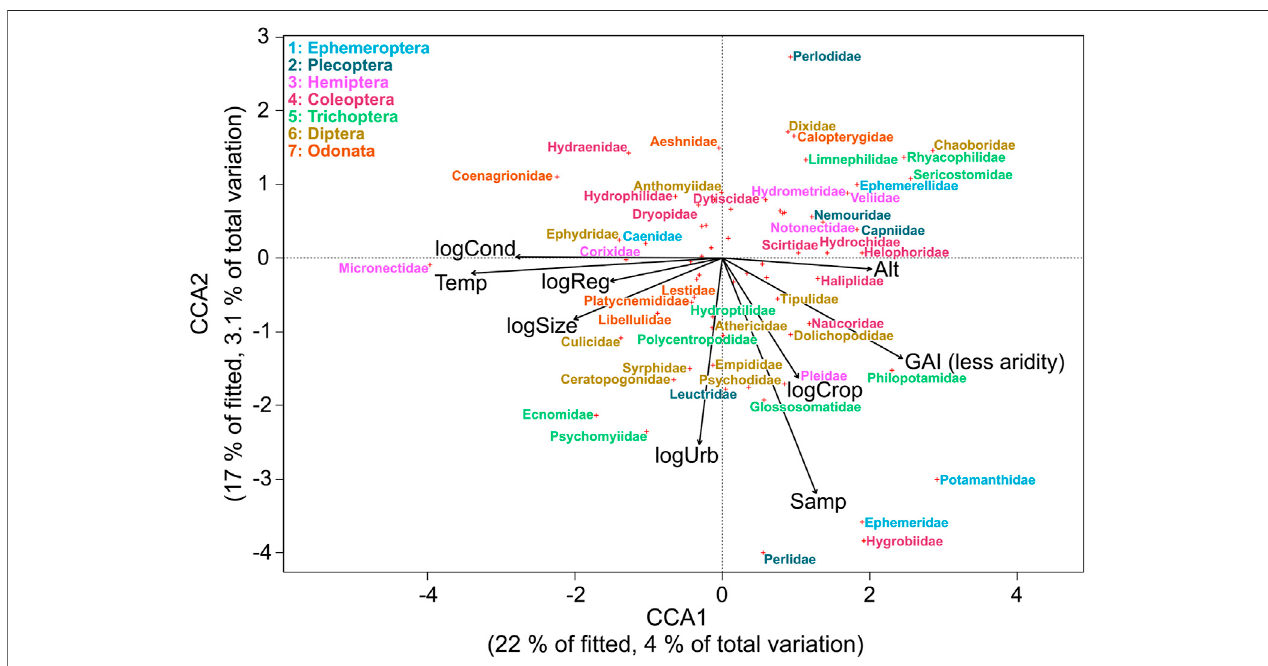
FIGURE 3 | CCA ordination distance triplot (scaling 1) with the relationship of environmental variables (altitude (Alt), water temperature (Temp), conductivity (log- transformed; logCond), number of samples per site (Samp), river area (log-transformed; logSize), degree of regulation (log-transformed; logReg), urban extent (log- transformed; logUrb), cropland extent (log-transformed; logCrop), Global Aridity Index (GAI)), and aquatic insect families in Northwest Africa. To avoid cluttering, overlapping labels were omitted from the plot.